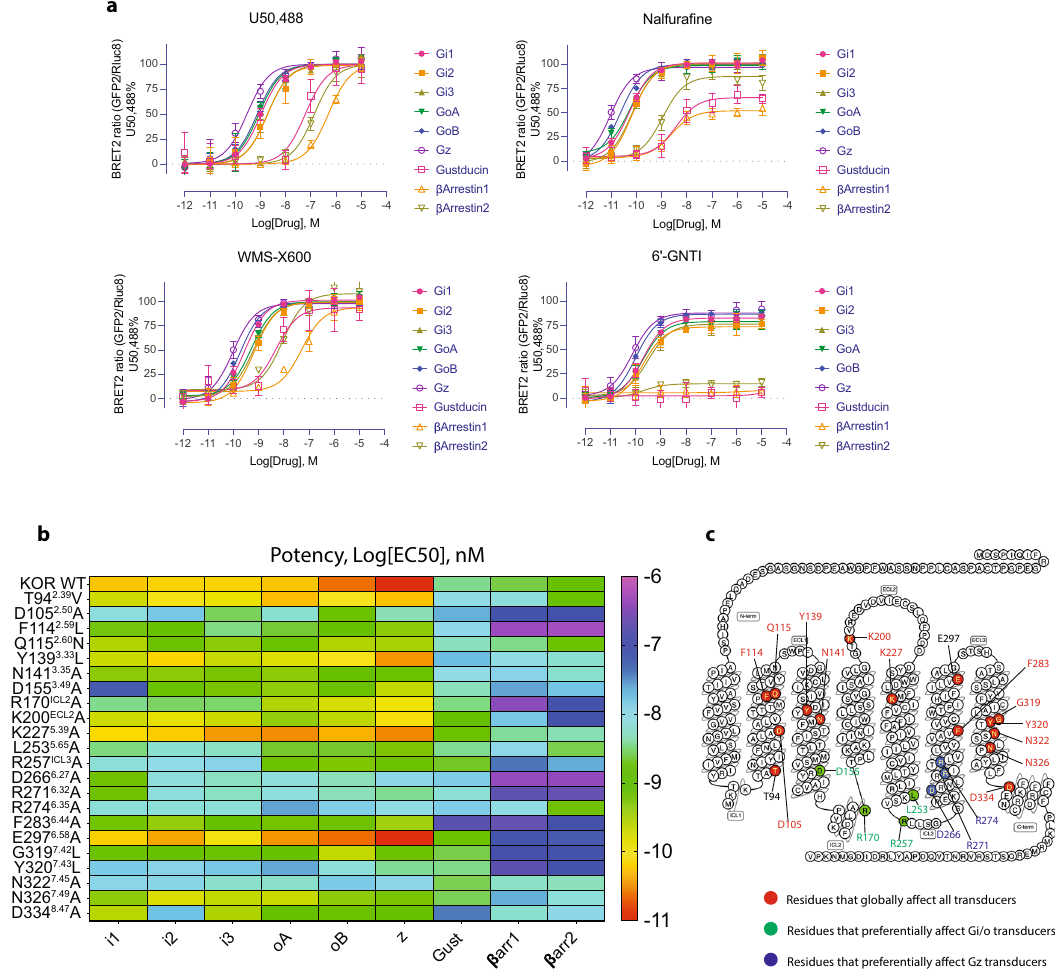
Fig. 5 | The functional characterization of ligand-speci fi c transducer coupling. a The functionally selective KOR agonists display preference towards unique transducer coupling. Data are expressed as the mean±SEM of three independent experiments ( n =3 experiments each done in duplicate). b The mutagenesis